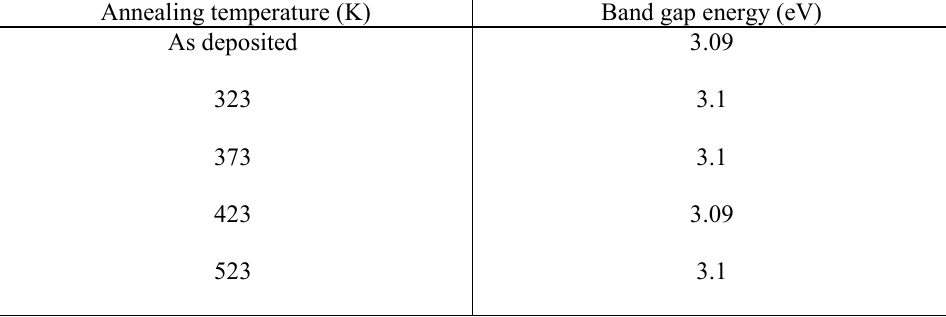
Table 1. Band gap energy of as deposited and annealed ZnTTBPc thin